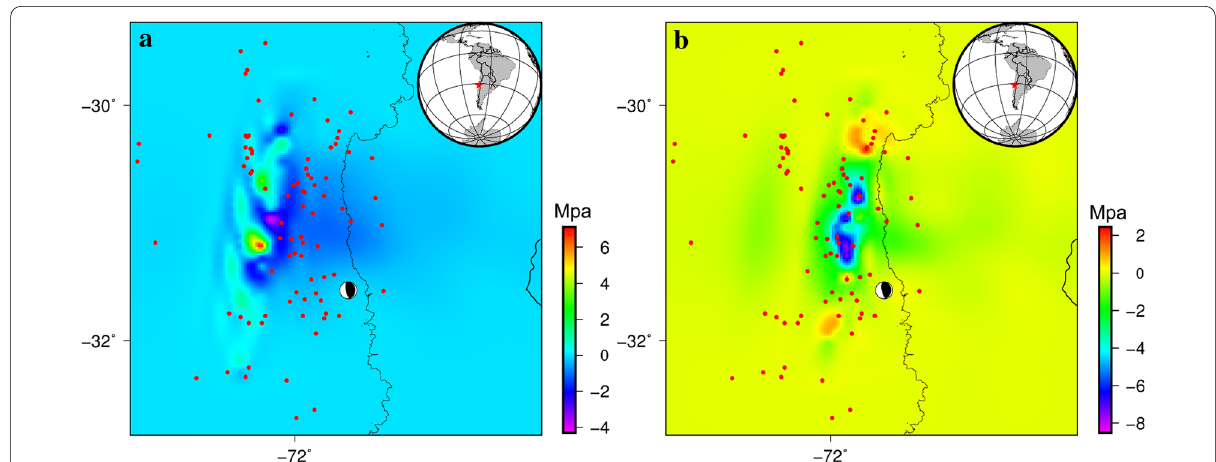
Fig. 10 Spatial distribution of the Coulomb stress change at the depth of 10 km ( a ) and 20 km ( b ). Red dots indicate the aftershocks with a focal depth of < 50